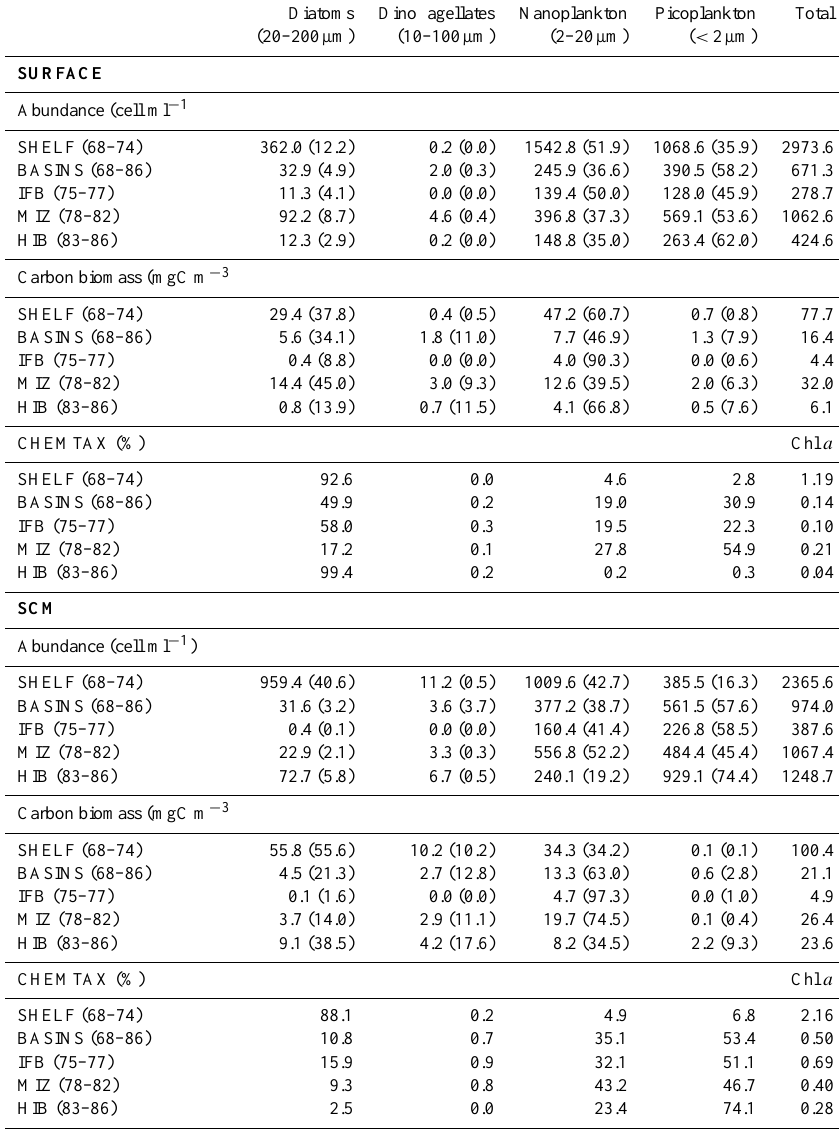
Table 2. Average abundances (cell ml − 1 ), carbon biomass (mgCm − 3 ) and relative contributions (%) derived from CHEMTAX for 4 phyto- plankton groups in surface and SCM